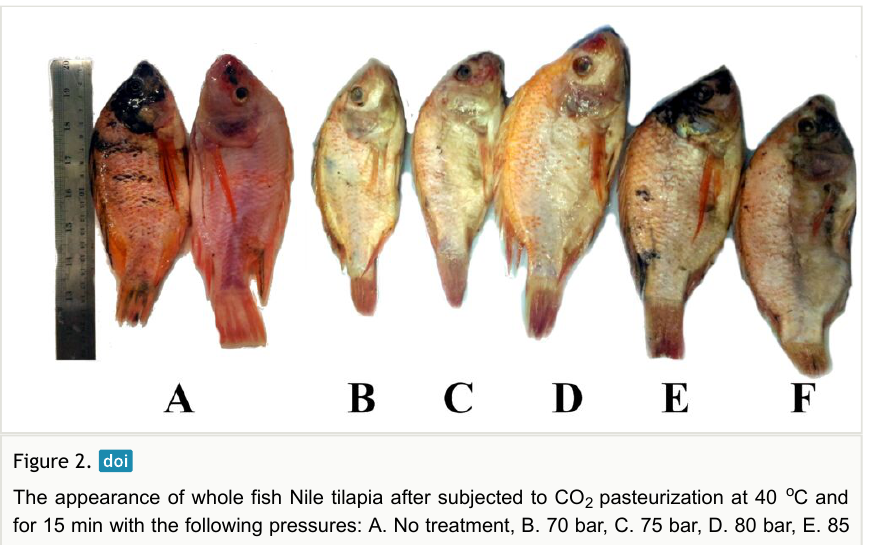
Figure 2. The appearance of whole fish Nile tilapia after subjected to CO pasteurization at 40 C and 2 for 15 min with the following pressures: A. No treatment, B. 70 bar, C. 75 bar, D. 80 bar, E. 85 bar, and F. 90 bar Before color reading, colorimeter had to be calibrated against supplied standard white. Each fillet was read on three different spots. Color was expressed in CIE L* (whiteness or brightness), a* (redness/greenness), and b* (yellowness/blueness) coordinates. Total Color differences ( ΔΕ ) were calculated according to CIEDE-2000 standard (Sharma et al. 00 2004).